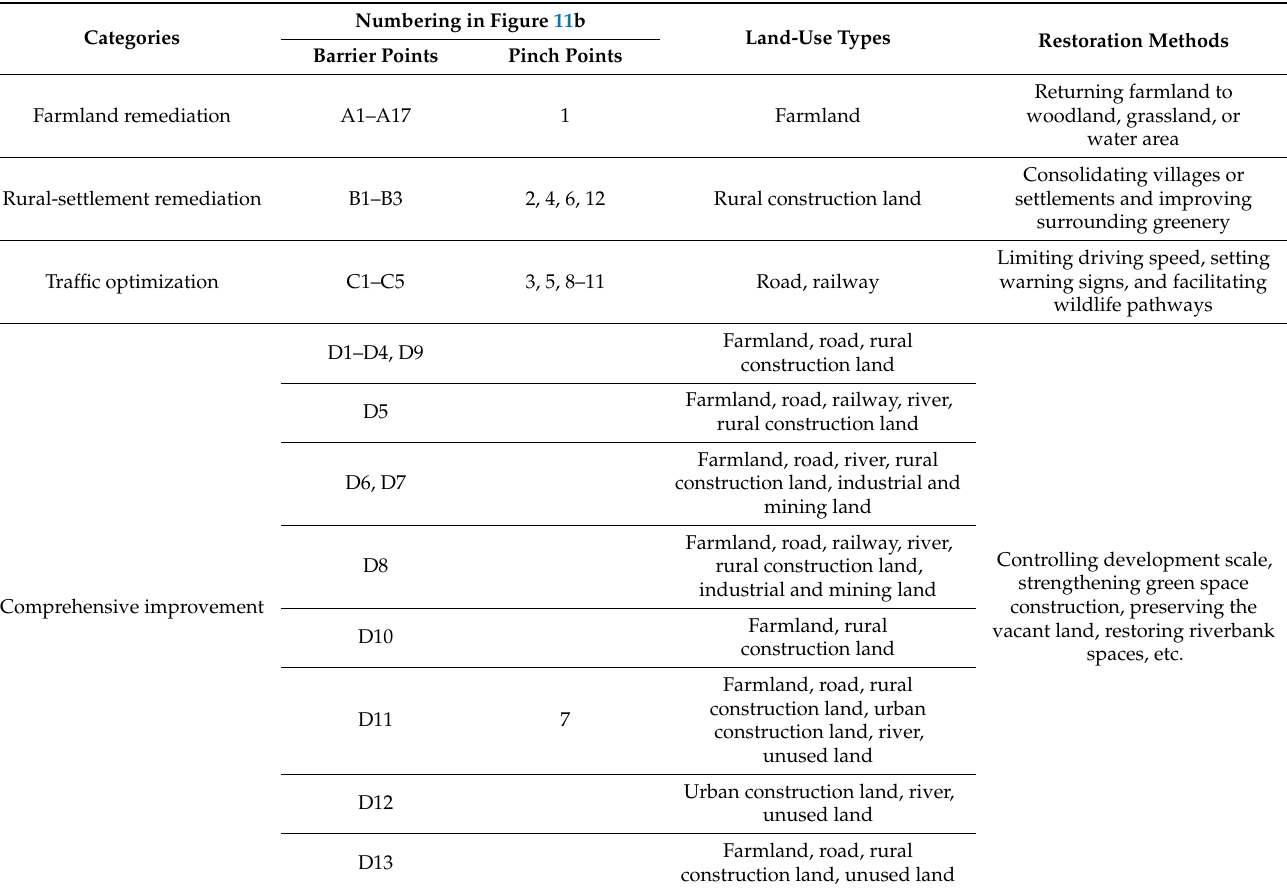
Table 8. Ecological-restoration